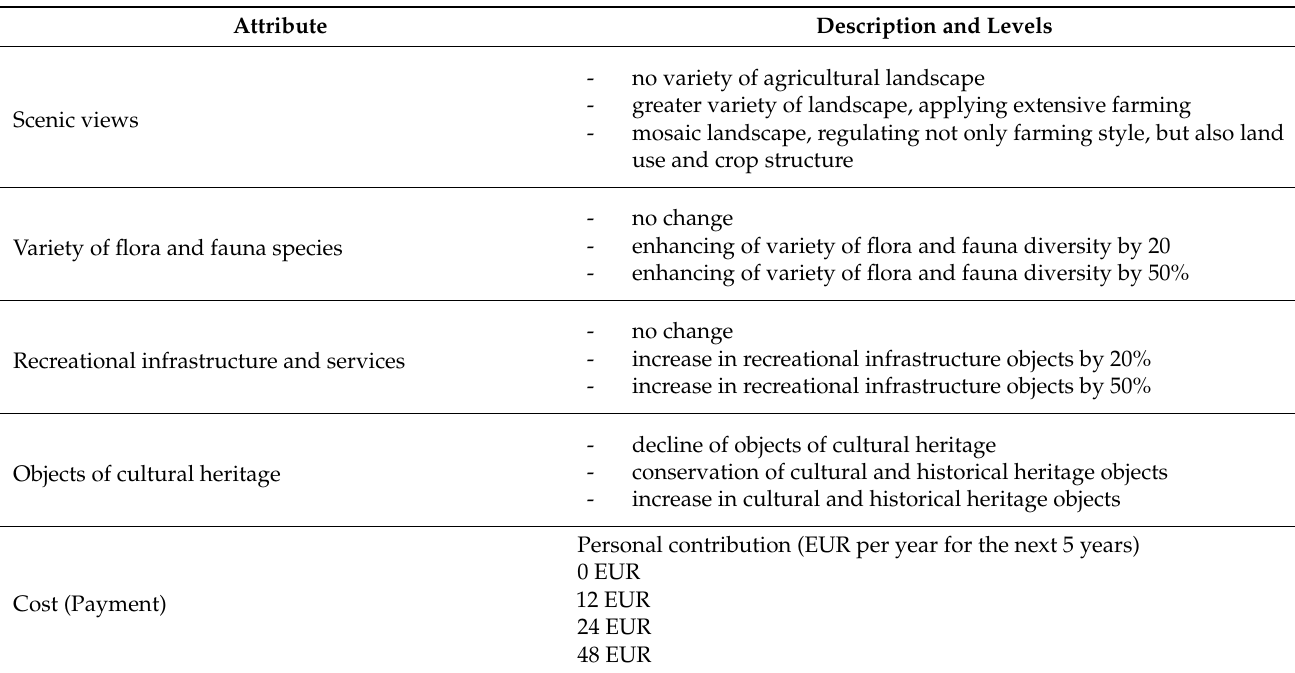
Table 1. Description of the representation of landscape attribute